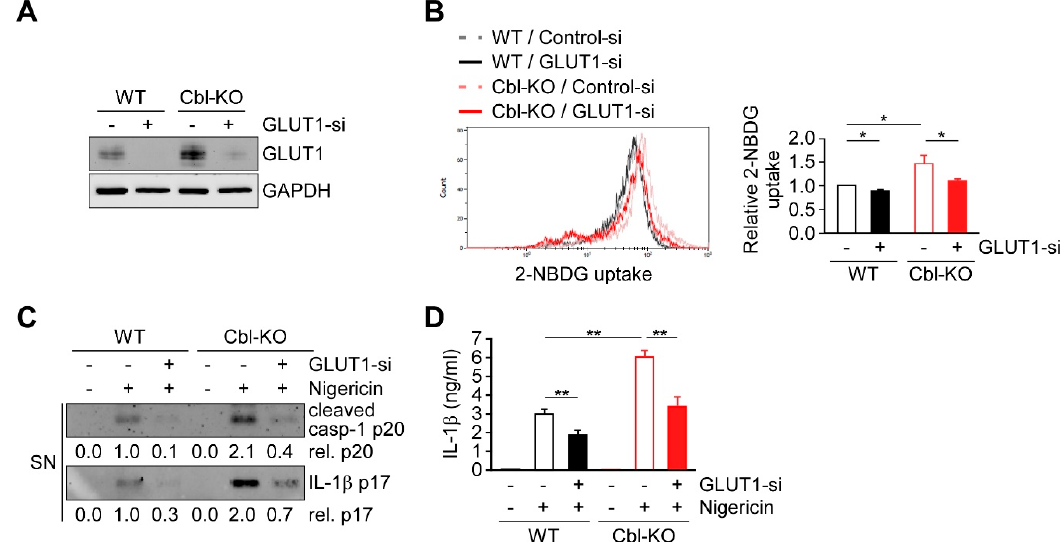
Figure 6. GLUT1 promoted cellular glucose uptake and NLRP3 inflammasome activation. ( A ) Immunoblot of GLUT1 in THP-1-derived macrophages treated with GLUT1 small interfering RNA (siRNA) or control siRNA. ( B ) Flow cytometry plots of three experiments showing glucose uptake in WT and Cbl-KO THP-1-derived macrophages treated with GLUT1 siRNA or control siRNA. ( C ) Immunoblot analysis of caspase-1 (p20) and IL-1 β (p17) in culture supernatants of WT and Cbl-KO THP-1-derived macrophages treated with GLUT1 siRNA or control siRNA and then treated with nigericin. ( D ) Enzyme-linked immunosorbent assay of IL-1 β in the supernatants of WT and Cbl-KO THP-1-derived macrophages treated with GLUT1 siRNA or control siRNA and then treated with nigericin. * p < 0.05; ** p < 0.01. All results are presented as the mean ± SD of the three independent experiments and were analyzed using Student’s t